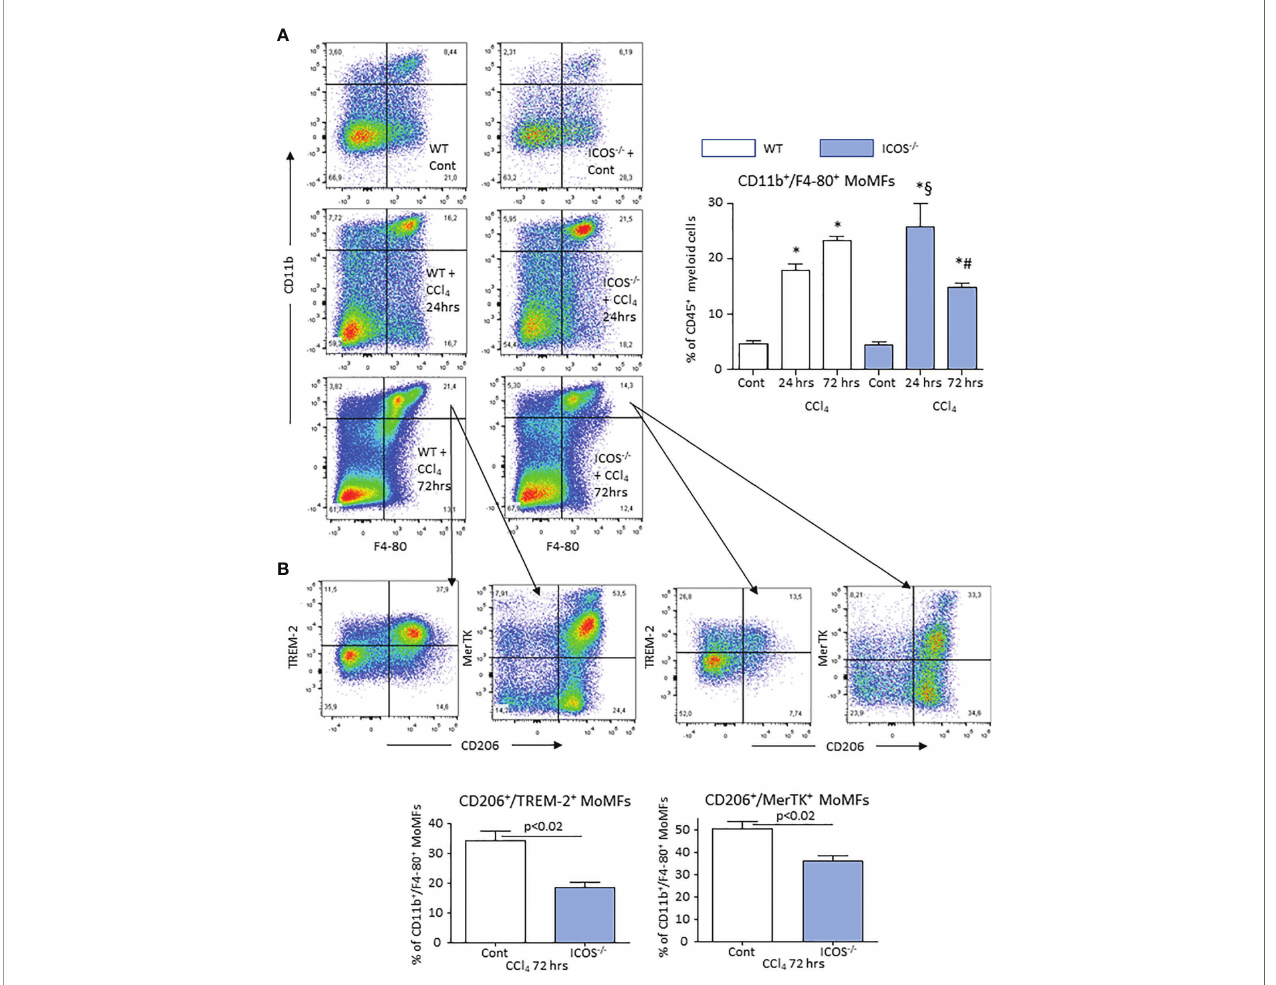
FIGURE 5 | ICOS de fi ciency causes the loss of reparative MoMFs during the resolution of acute liver injury. The prevalence of liver CD11b + /F4-80 + MoMFs during the evolution of acute liver injury induced in wild-type and ICOS -/- mice receiving CCl 4 was monitored by fl ow cytometry 24 or 72 hours after challenge with the toxic agent (A) . Characterization of the co-expression of CD206, TREM-2 and MerTK among CD11b + /F4-80 + MoMFs in fi ltrating the liver during the resolution of acute liver damage (B) . The results are expressed as mean ± SD of 3-4 different cell preparations. *p < 0.001 vs the relative controls; # p < 0.01 vs WT CCl4 24 hrs; § p < 0.01 vs WT CCl4 72